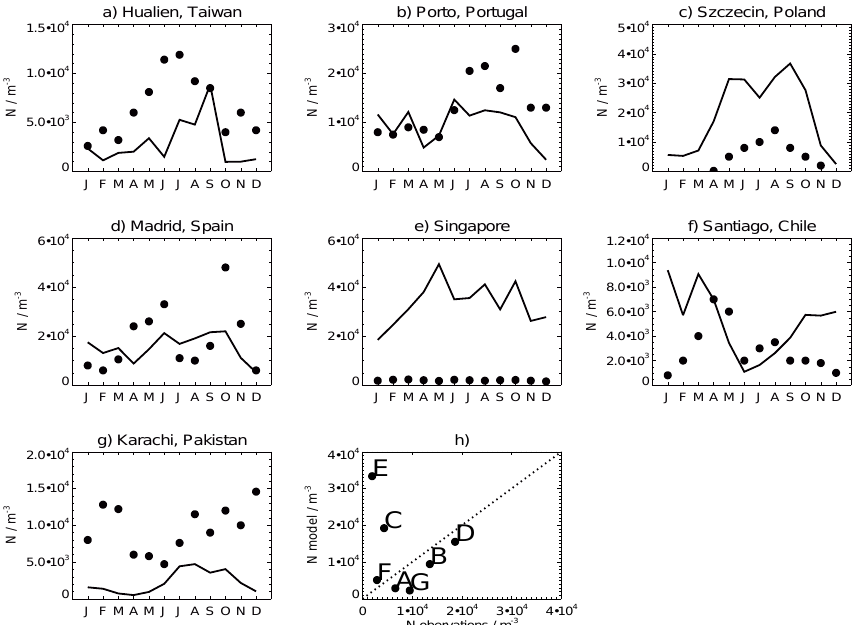
Figure 3. Evaluation of simulated fungal spore number concentrations. (a–g) Comparison of observed (circles) and simulated (black lines) monthly mean concentrations. (h) Comparison of simulated and observed annual mean concentrations. Observations are from Ho et al. (2005), Sousa et al. (2009), Grinn-Gofron et al. (2011), Herrero et al. (2006), Lim et al. (1998), Henriquez et al. (2001), and Hasnain et al.